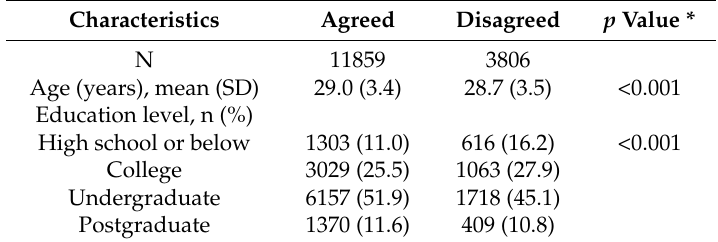
Table A1. Comparison of characteristics among women who agreed and disagreed to participate in